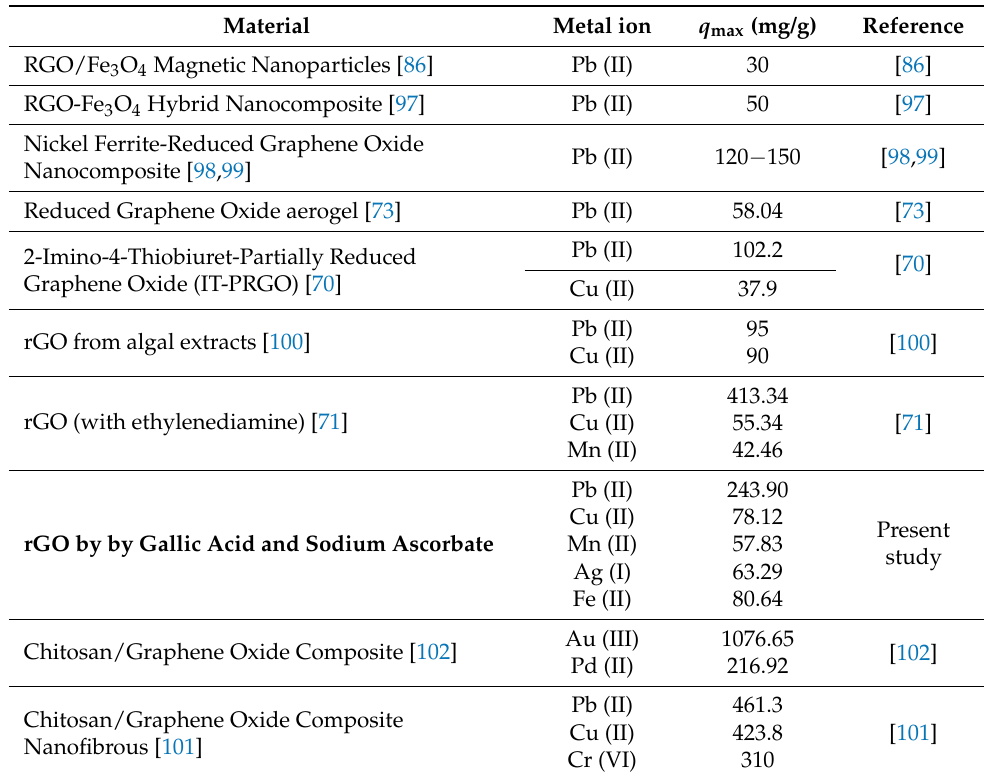
Table 2. Comparison of adsorption capacity of metal ions ( q max , mg/g) of rGO with other graphene